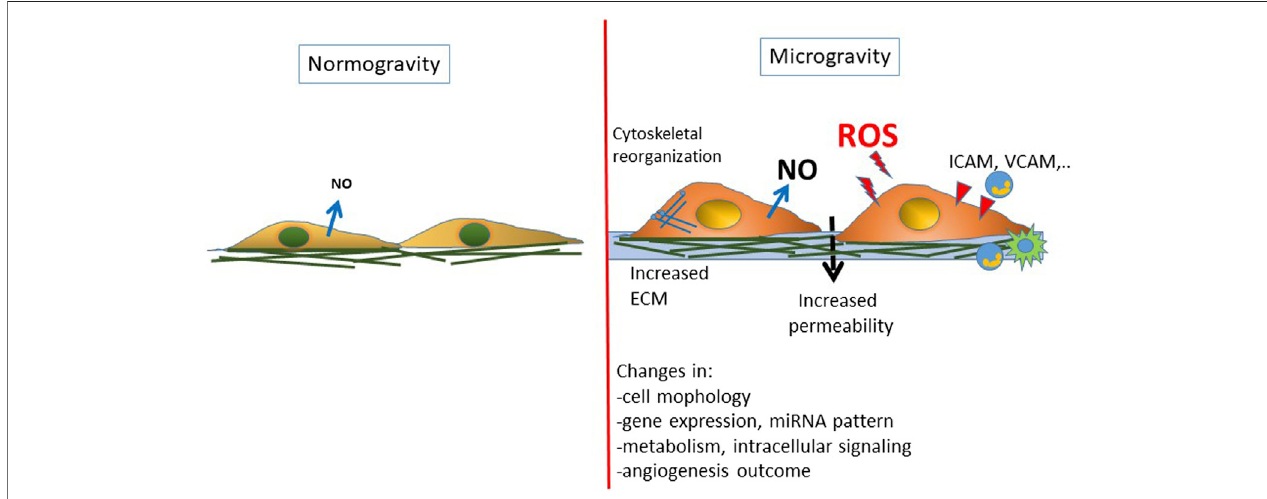
FIGURE 2 | Schematic representation of the changes reported on endothelial cells exposed to real or simulated microgravity. A general condition of endothelial dysfunction is found associated with an in fl ammatory/prooxidative phenotype.